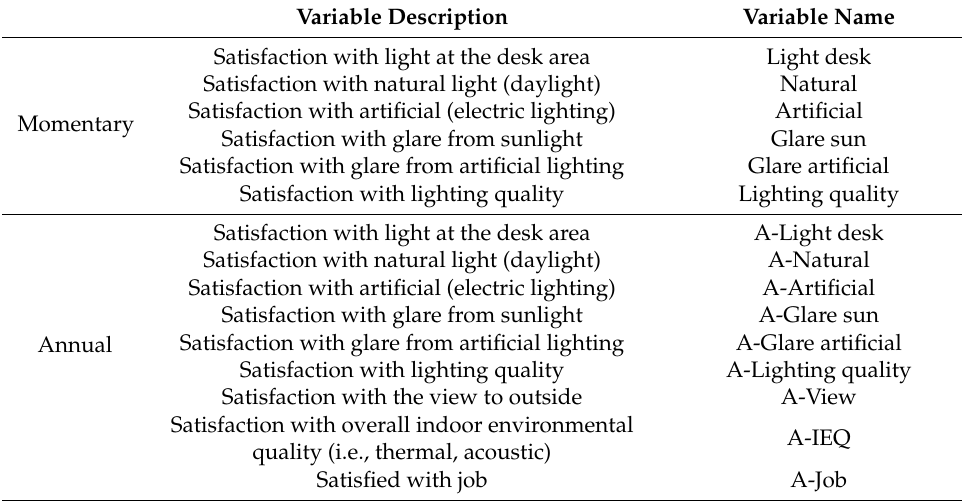
Table 5. Description of the variables included in the analysis with their variable name. Satisfaction variables are all on a 7-point Likert scale (1 = very satisfactory to 7 = very unsatisfactory). Variable